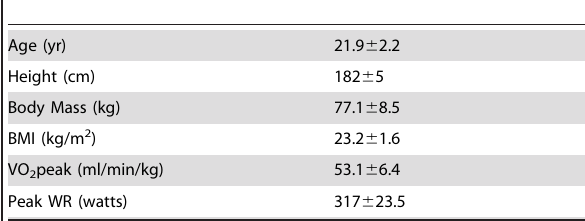
Table 1. Subject characteristics (n